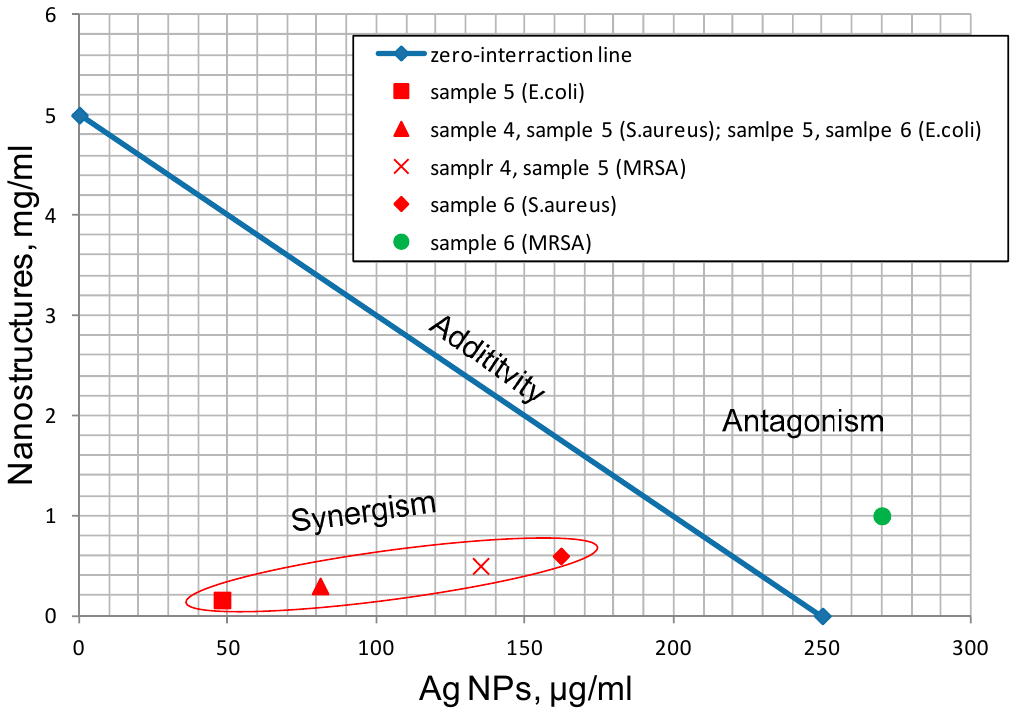
Figure 17. Isobologram of the combined action of γ -Al 2 O 3 nanostructures and Ag nanoparticles. The content of silver was taken on the basis of 27 wt% metal content in the